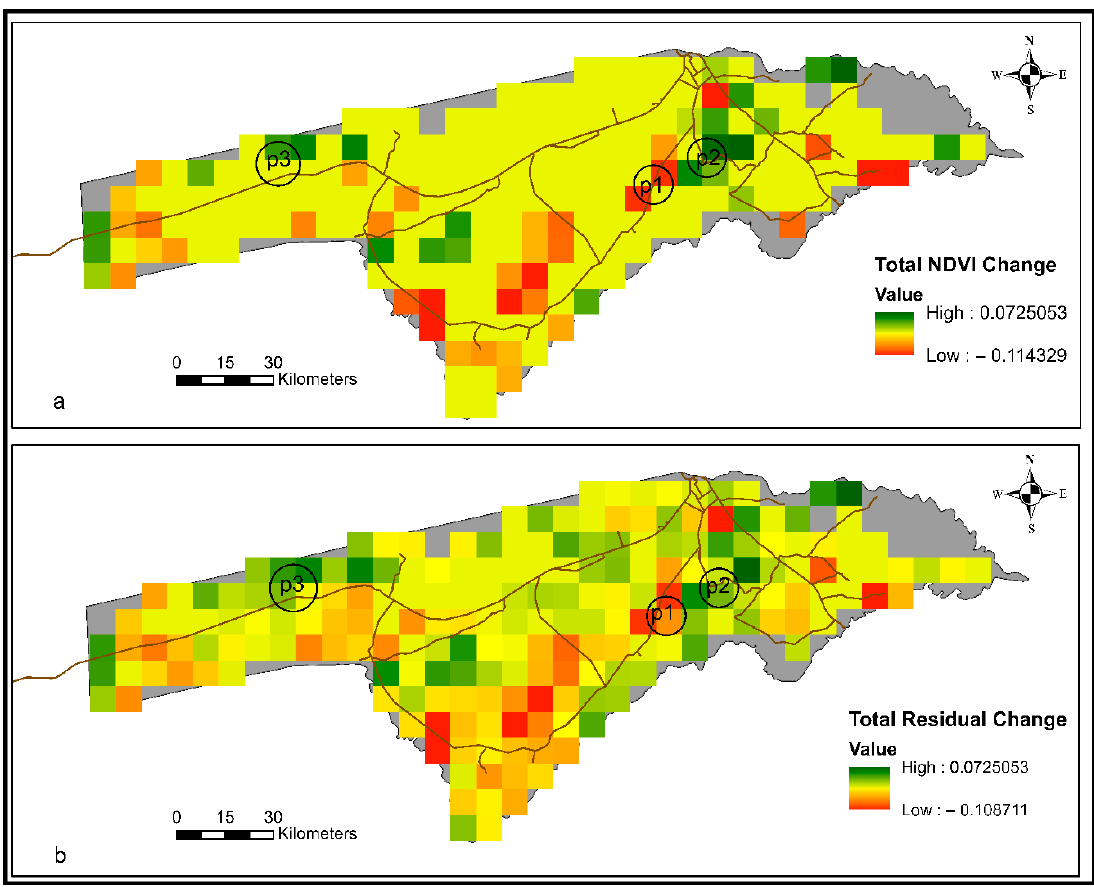
Figure 3. The spatial distribution of ( a ) the total change in NDVI and ( b ) residual change across the Zambezi Region. p1–p3 are the locations where historical Google Earth images were visually compared (Figure 4). The gray background along the Zambezi (east) and Chobe (south) Rivers are floodplains.